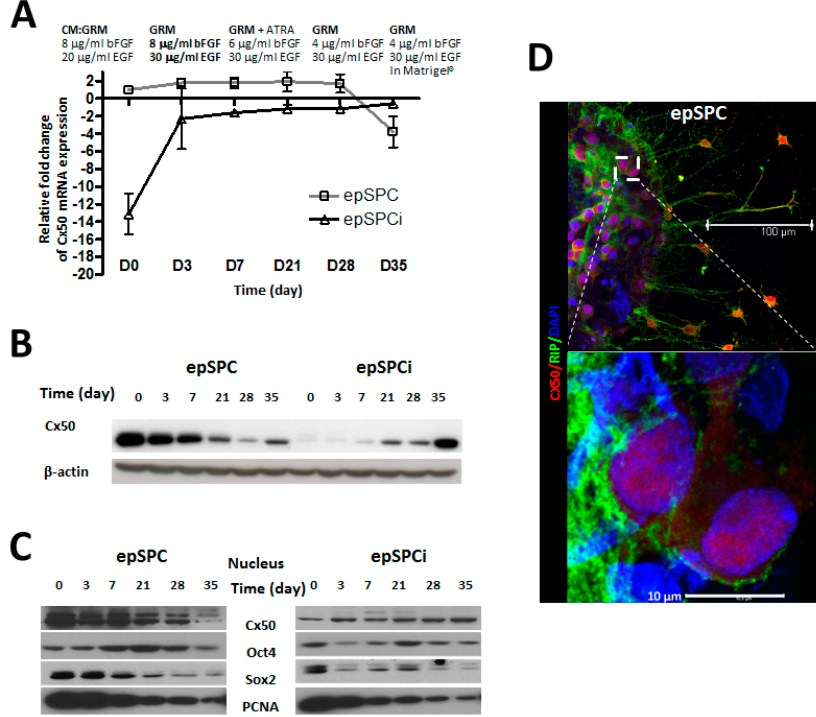
Figure 2. Evolution of Cx50 mRNA expression of epSPC and epSPCi during directed differentiation to oligodendrocytes. ( A ) Changes in Cx50 mRNA expression determined by qRT-PCR during